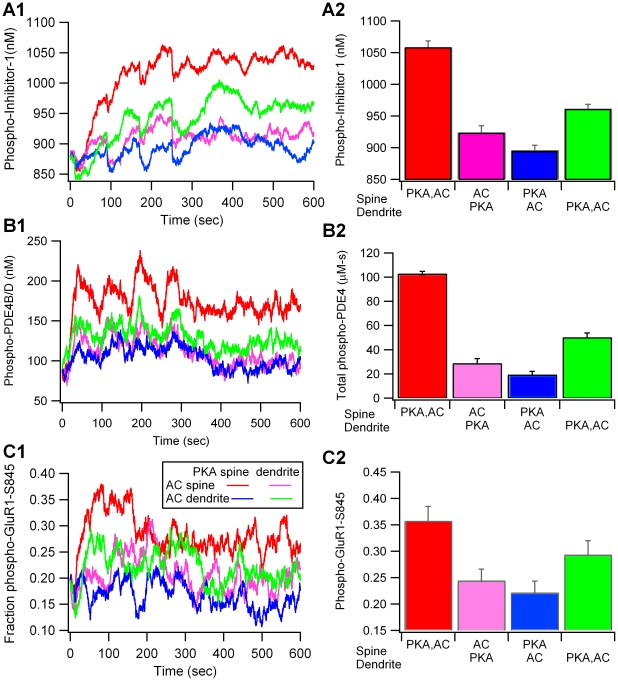
Phosphorylation of PKA targets is greatest when PKA is colocalized with cAMP production either in the spine or in the dendrite.(A1) Phospho-inhibitor-1 is greatest when PKA is colocalized with adenylyl cyclase (AC) in the spine head (red trace) and second largest when PKA is colocalized with AC in the dendrite (green trace). The early decrease in phosphorylation is caused by transient, calcium activation of calcineurin. (A2) Bar graph shows mean and s.e.m. of phospho-inhibitor-1 (n = 5 for each condition). Colocalization of AC and PKA produces significantly greater phospho-inhibitor-1 than when AC and PKA are anchored apart. (B1) Phosphorylation of PDE4s by PKA is greatest when PKA is colocalized with cAMP production either in the spine or in the dendrite. Phospho-PDE4 is the sum of phospho-PDE4B and phospho-PDE4D. (B2) The mean and s.e.m. for phospho-PDE4 represents the total activity (area under the curve) of phosphodiesterase type 4B and type 4D. (C1) Fraction of GluR1 phosphorylated on Ser845 is greatest when PKA is colocalized with both cAMP production in the spine and with the GluR1 target. (C2) The mean and s.e.m. for phospho-GluR1-S845 are calculated over 5 trials.